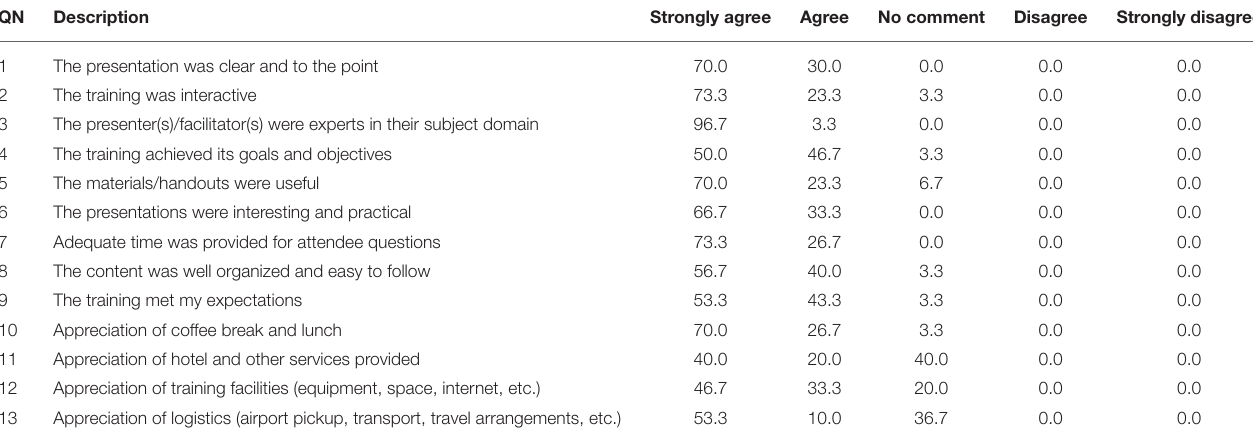
TABLE 7 | Participants’ response to the technical capacity building support (in %).